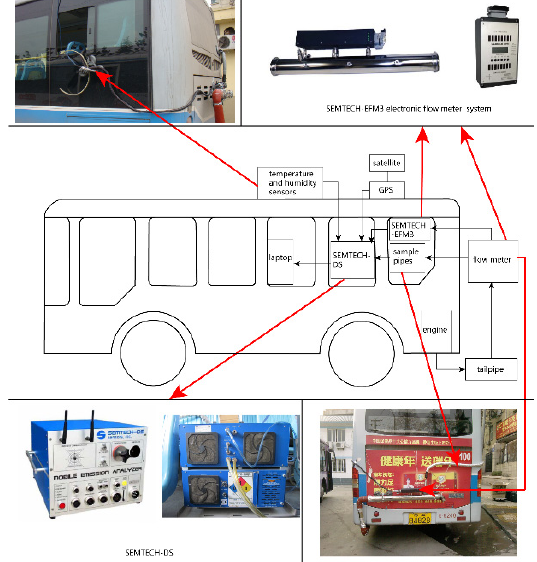
Figure 2. On-road PEMS test